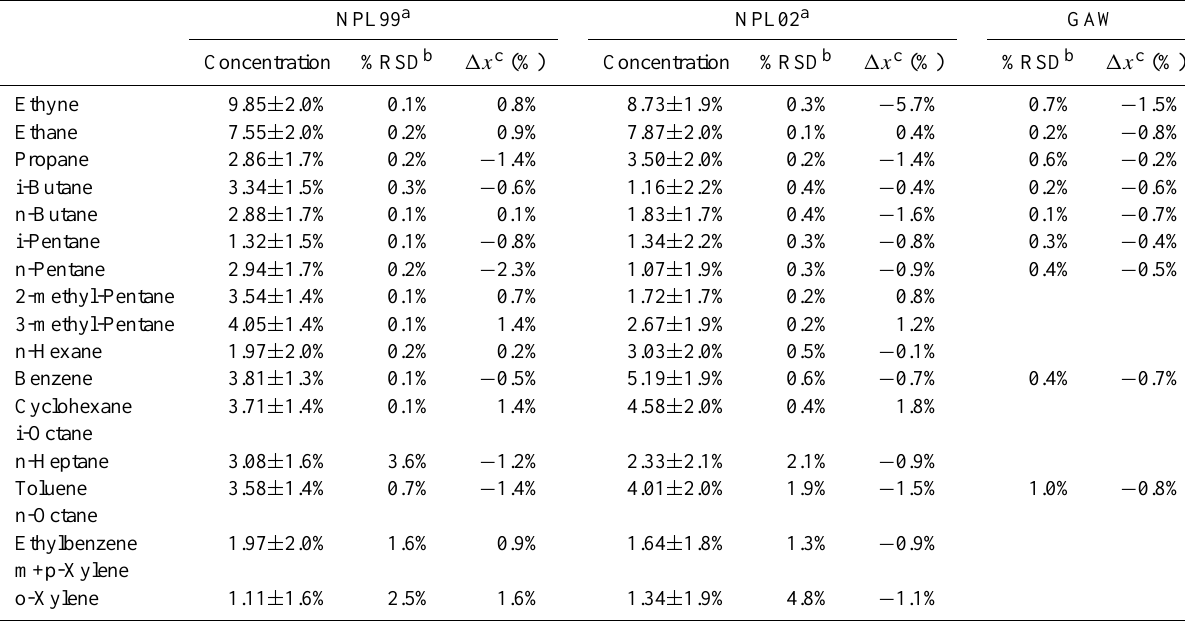
Table 3. Results of comparison with CARIBIC-1 and GAW standards (see